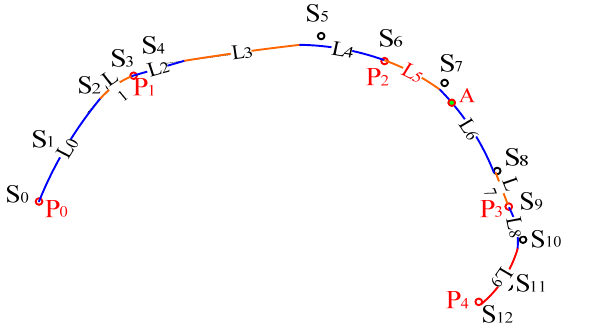
Figure 11. Key points, control points and curve segments of a shape-preserving quasi-uniform B-spline curve.